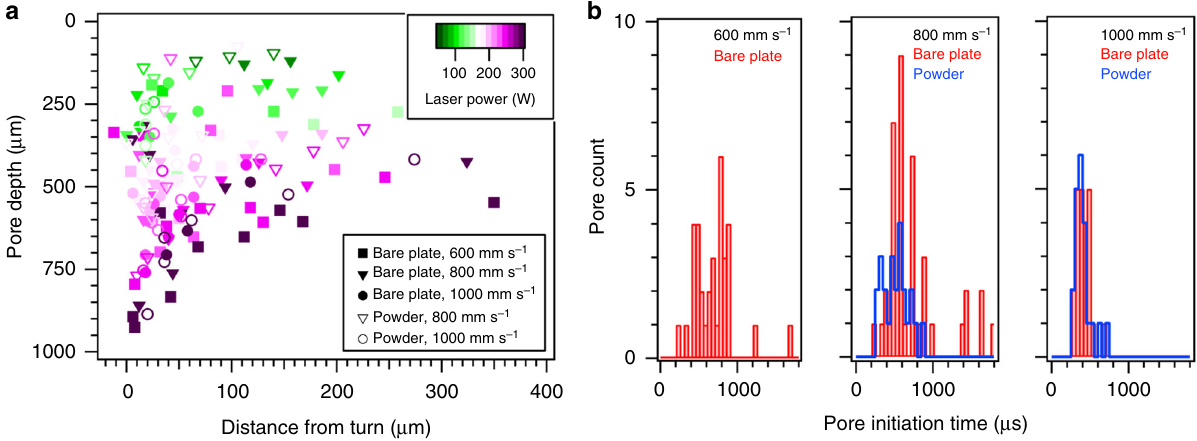
Fig. 2 Properties of pores formed during LPBF of Ti – 6Al – 4V in the laser turn point region as a function of laser power and steady-state scan speed. All turn point condition scans were performed at full laser power. a Depth of pore relative to the substrate surface as a function of distance from the turn point of the laser. b Histograms of the pore initiation time, τ p , after the laser completed the turn point for three different scan speeds where t turn = 0 µ s. Each histogram includes pores produced with all laser powers (50 – 300 W) at the speci fi ed scan speed with (blue line) and without (red line) powder. No pores were formed in the turn point region prior to the laser turn in these